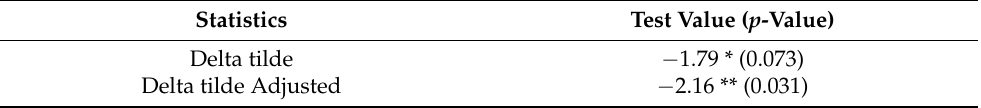
Table 4. Results of Slope heterogeneity test.